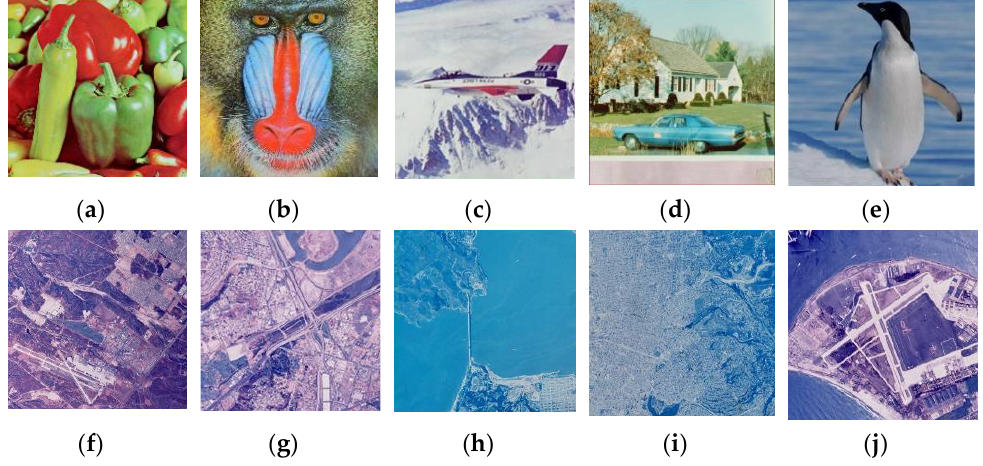
Figure 14. Color decrypted images: ( a ) Peppers; ( b ) Baboon; ( c ) Airplane; ( d ) House; ( e ) Penguin; ( f ) Sky; ( g ) Railway; ( h ) Sea; ( i ) Water; ( j ) Building. Table 2. The URL of the plain images.